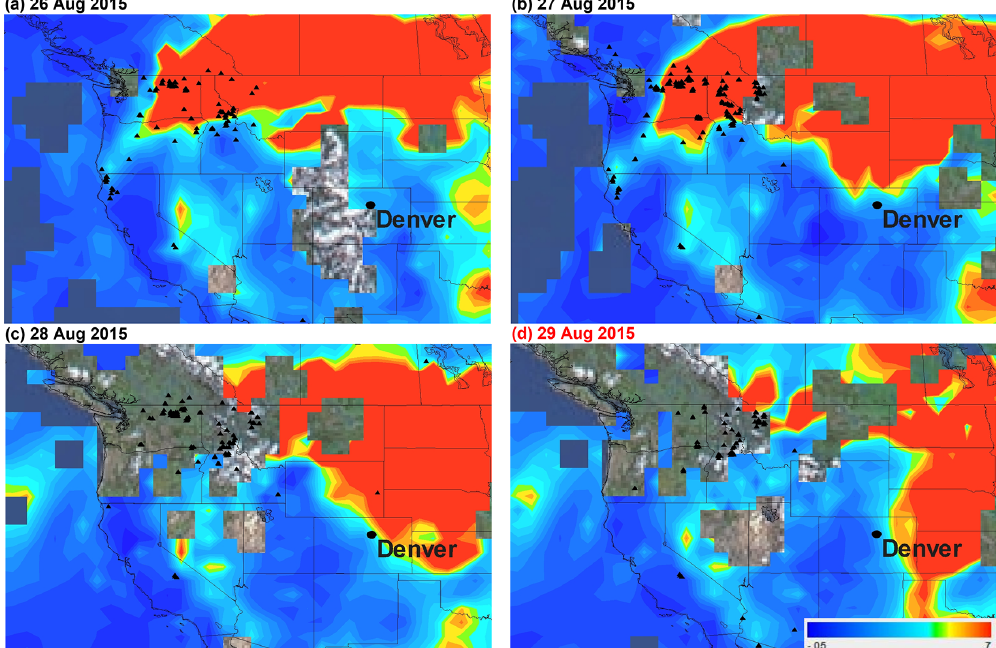
Figure 6. Same as Fig. 4 but for the third major haze event between 26 and 29 August 2015. The haziest day from the CDPHE data is labeled in red (i.e., event